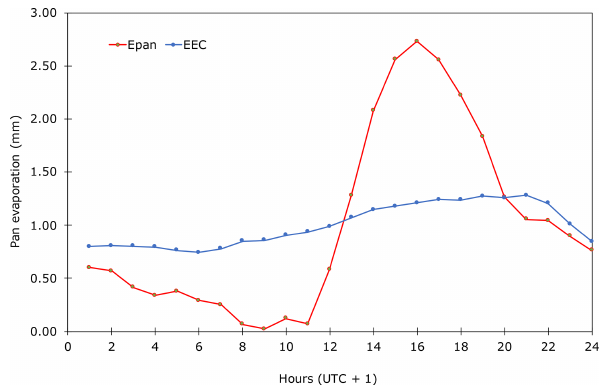
Figure 8. Mean daily cycle of the normalised pan evapora- tion ( E pan ) and the EC evaporation ( E EC